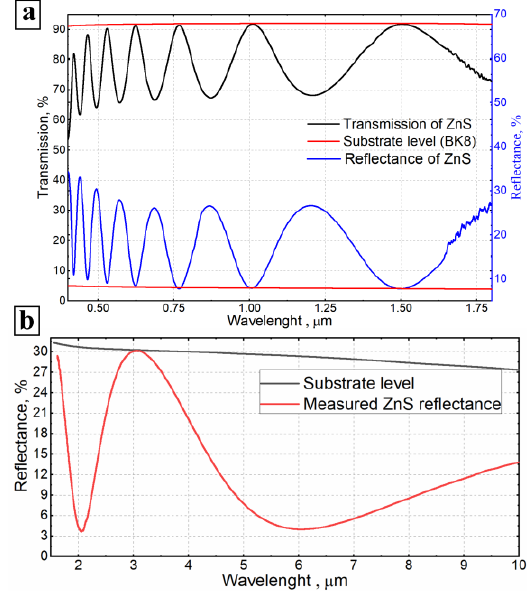
Figure 3. ( a )—transmission and reflection spectra of a ZnS monolayer on BK8 substrate; ( b )—reflection spectrum of a ZnS monolayer.